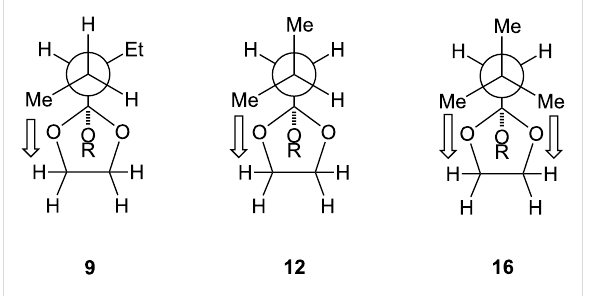
Figure 4: Newman projections of 9 , 12 and 16 (viewed along C β→ C α